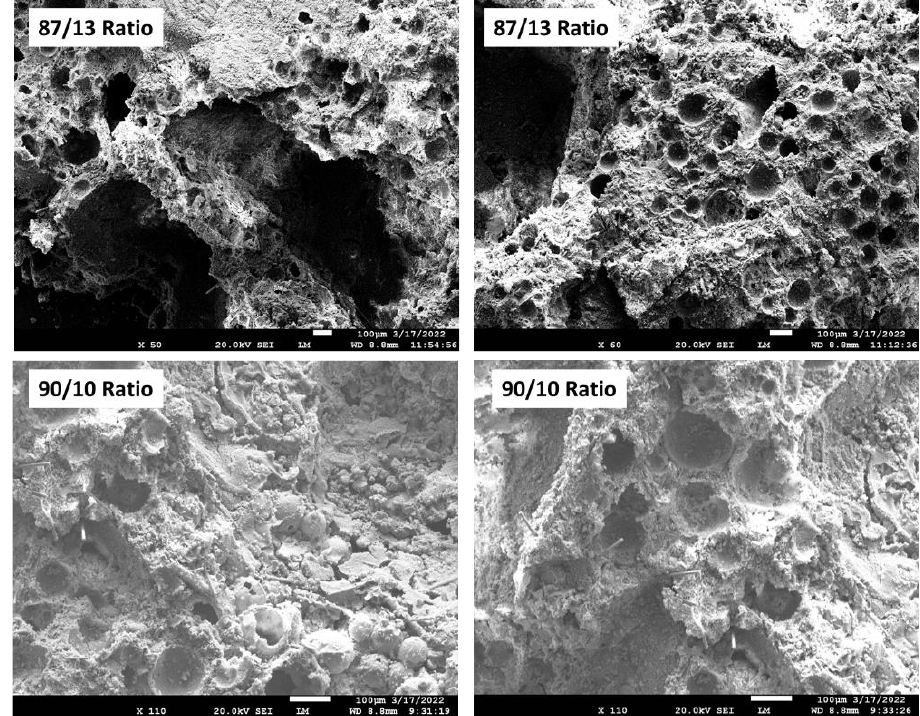
Figure 34. Microstructures of 90/10 and 87/13 samples, autoclaved at 250